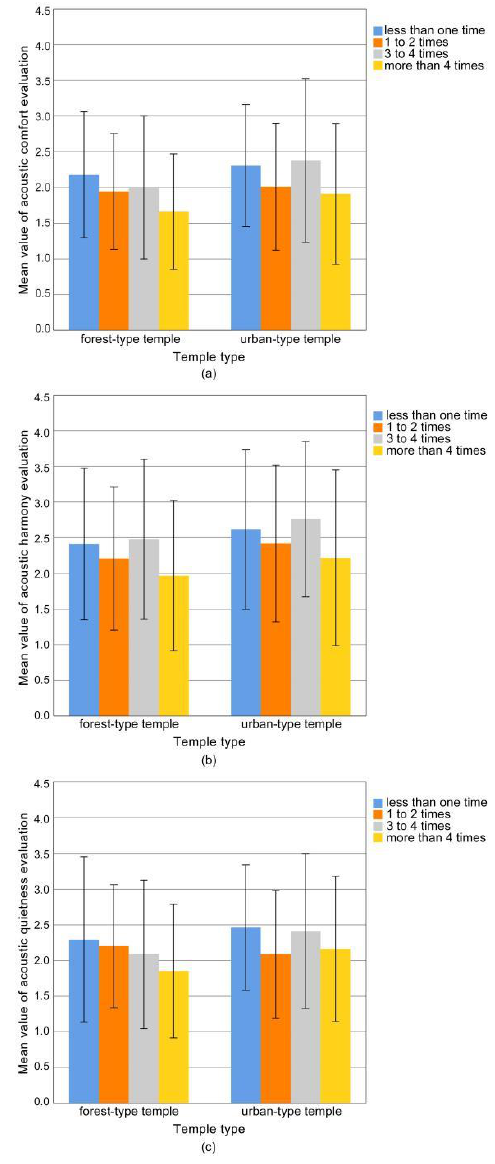
Figure 6. The evaluation value and standard deviation of acoustic environment by different re- spondents’ average number of annual visits to the temple: ( a ) comfort; ( b ) harmony; ( c ) quietness.